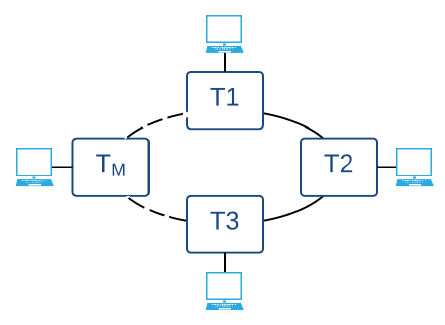
Figure 4. Mono-ring network